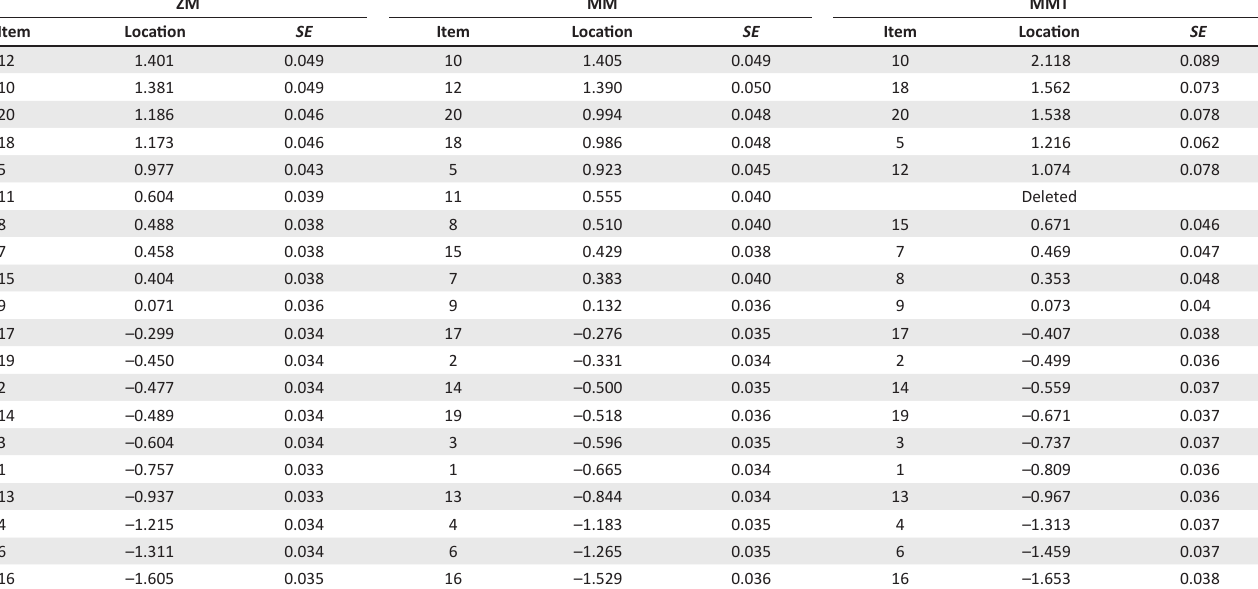
TABLE 7: Item difficulty locations and standard error: ZM, MM and MMT